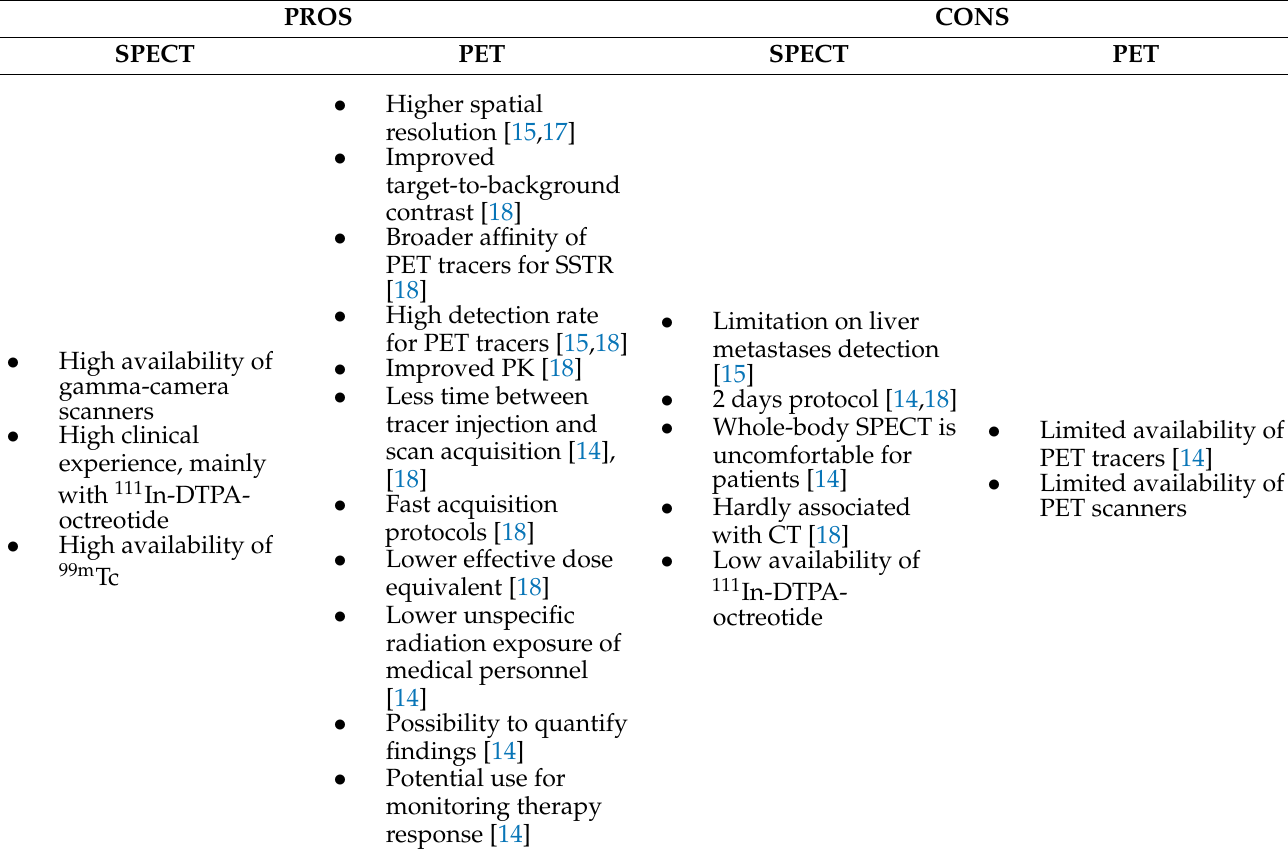
Table 4. Advantages and disadvantages for PET and SPECT imaging in